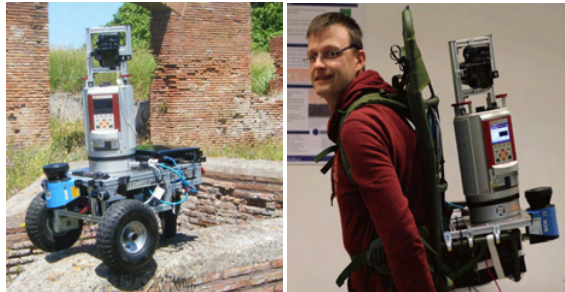
Figure 1: Left: The robot Irma3D. Videos of the system are avail- able at http://www.youtube.com/AutomationAtJacobs Right: The backpack mobile mapping